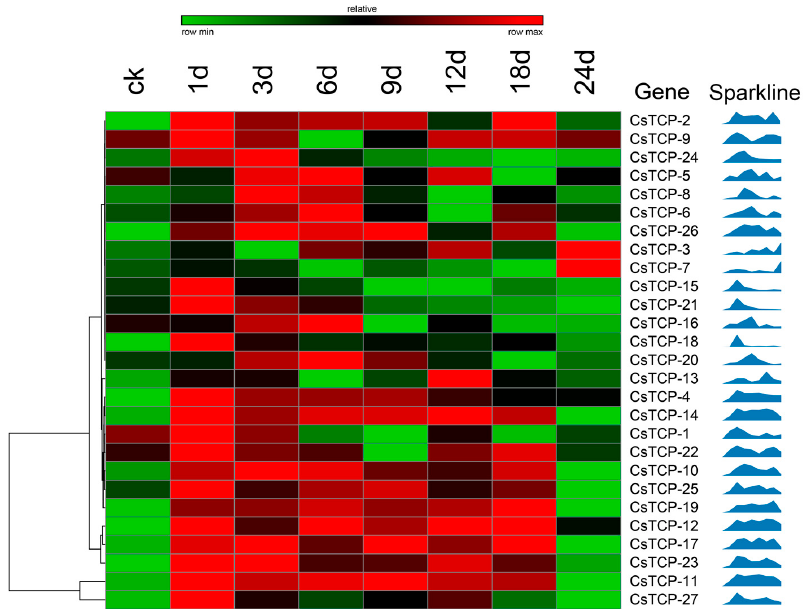
Figure 4. Responsive expression of CsTCP genes under WMV stress. The gene expression profiles were investigated through qRT-PCR in day 1, 3, 6, 9, 12, 18, and 24 under WMV stress, compared with in CK without WMV treatment. The color scale showed that the increasing expression levels form black to red on the top, and the sparkline was shown on the